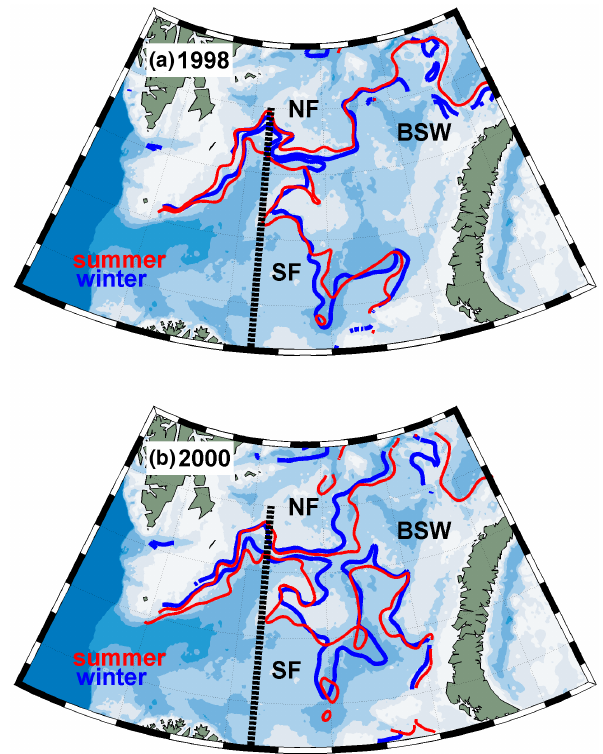
Figure 13. Seasonal and interannual variability of the Southern Front (SF) and Northern Front (NF). (a) 1998 and (b) 2000; (red line: summer; blue line: winter). The bathymetry and Vardø section are